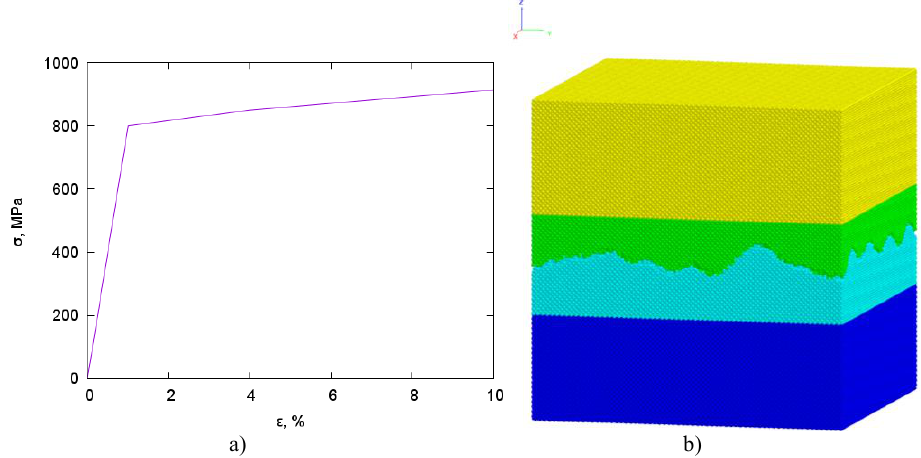
Fig. 1. Stress-strain curve for steel (a) and a model specimen as packing of automata